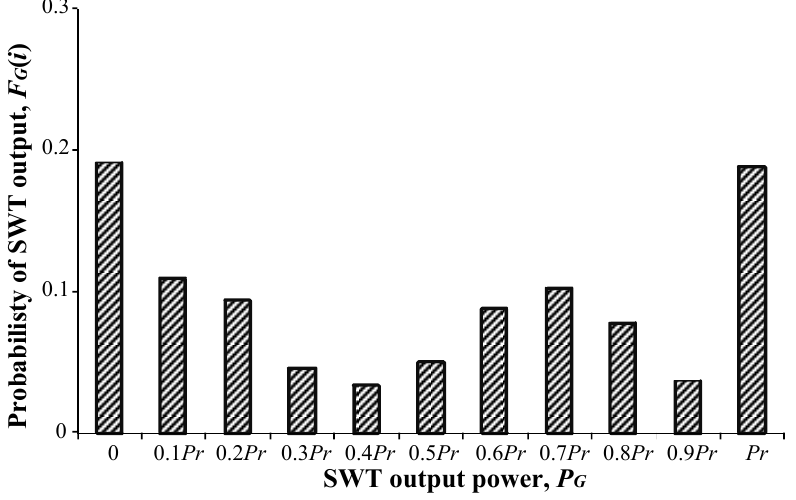
Figure 1. The probabilistic distribution of SWT output power, M =